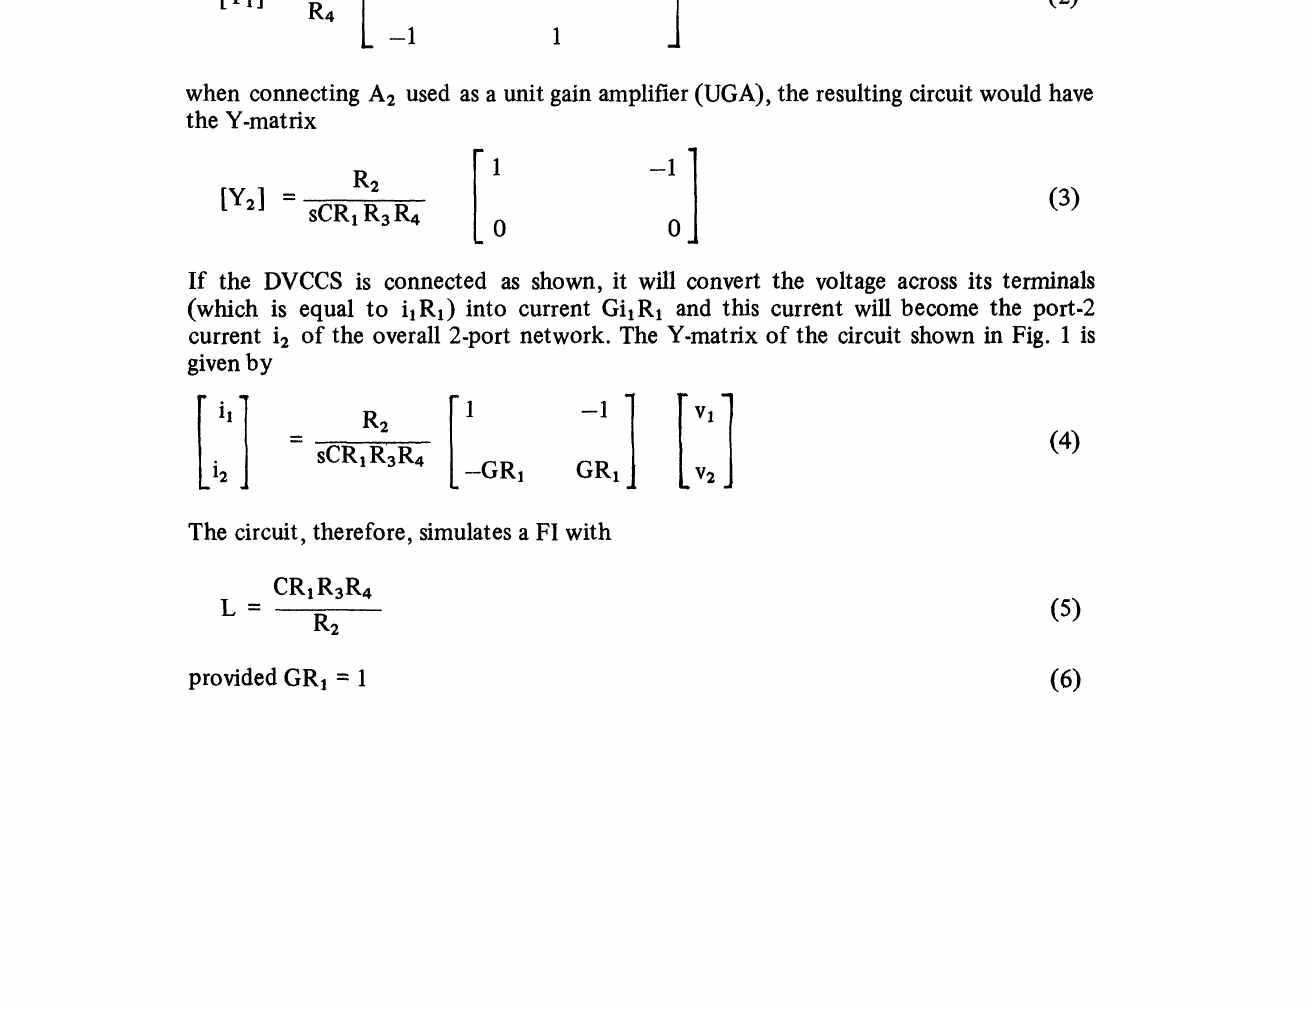
FIGURE A circuit configuration for simulating a lossless floating inductance using a single GIC; L CR R R 4/R provided